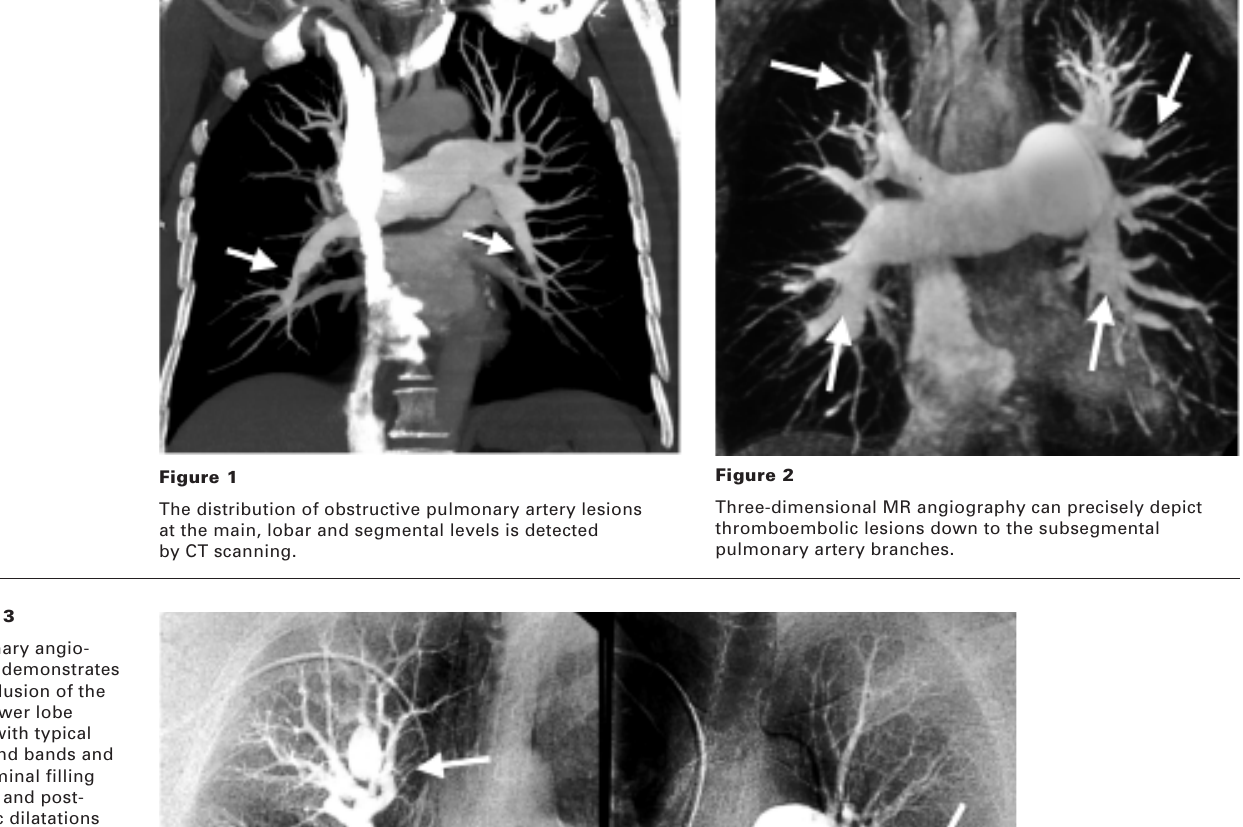
Pulmonary angio- graphy demonstrates the occlusion of the right lower lobe artery with typical webs and bands and intraluminal filling defects and post- stenotic dilatations in bilateral segmental